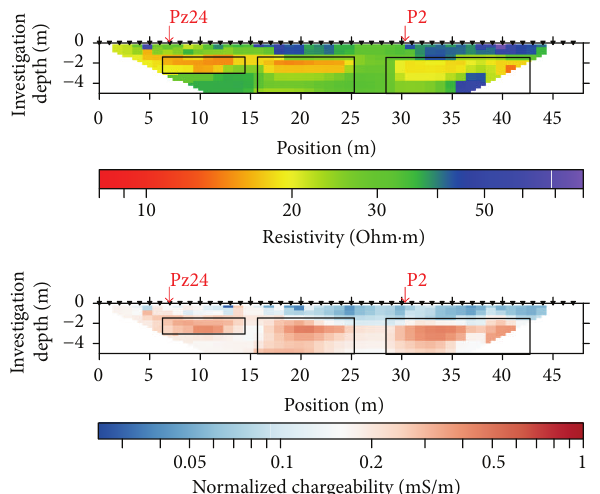
Figure 4: Resistivity and normalized chargeability sections across the plume for the temporary electrical profile, on 6th March 2014. The black rectangles highlight zones of lower resistivity and higher normalized